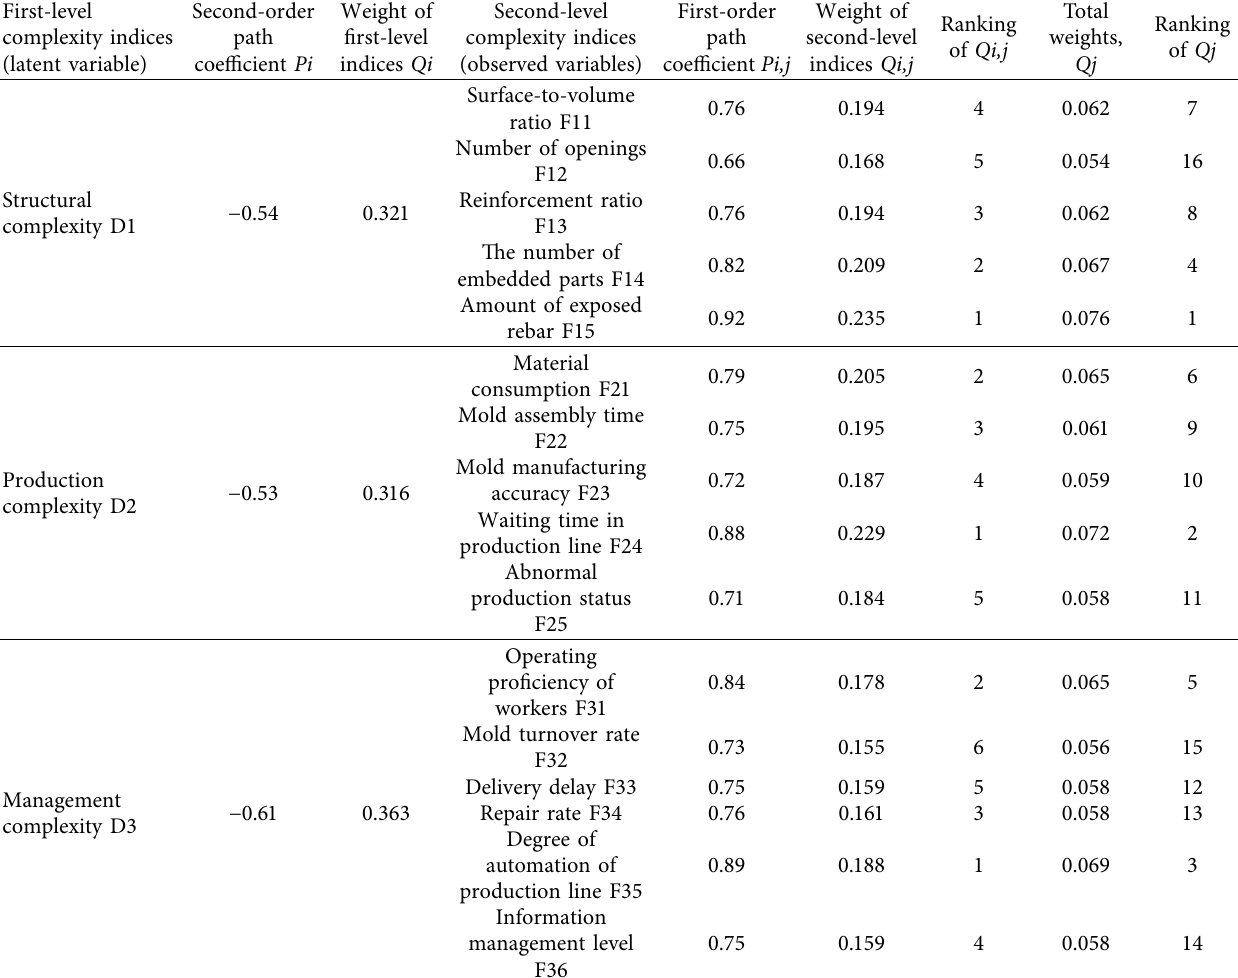
Table 12: Ranking for the influence weights of the complexity indices on production